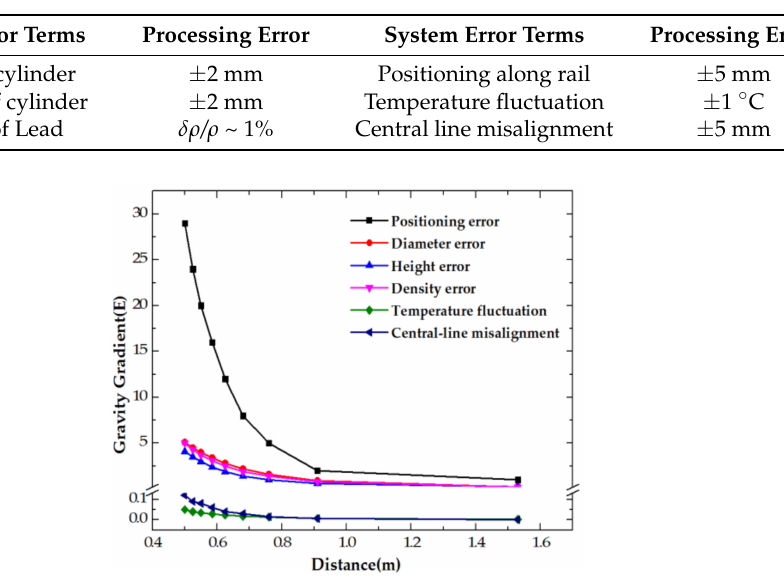
Table 2. Processing system error of the calibration experiment setup.